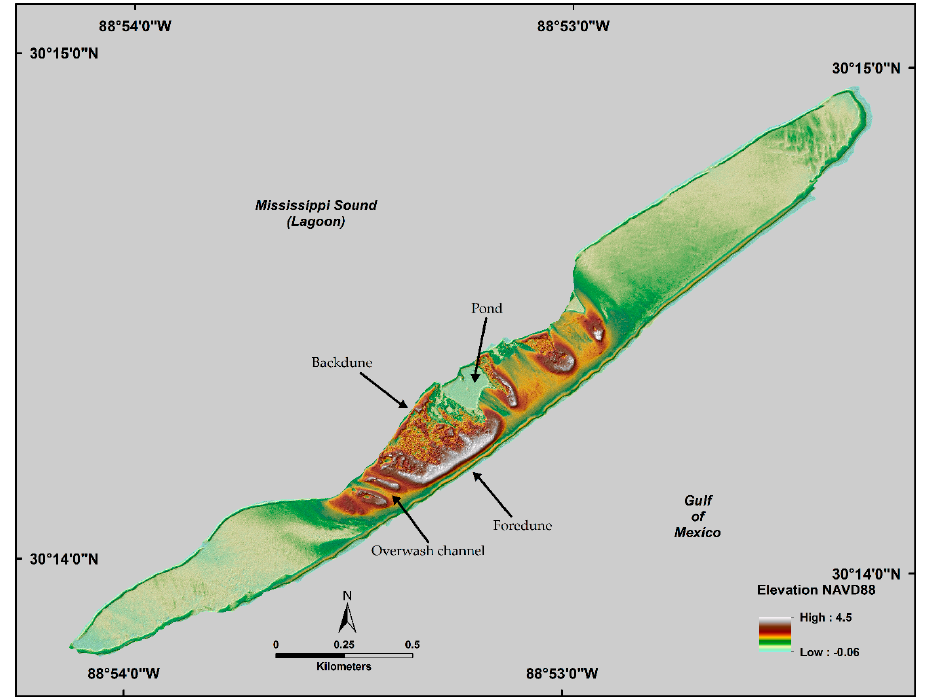
Figure 4. DTM of East Ship Island (2012) delineating the island’s minimum and maximum elevations